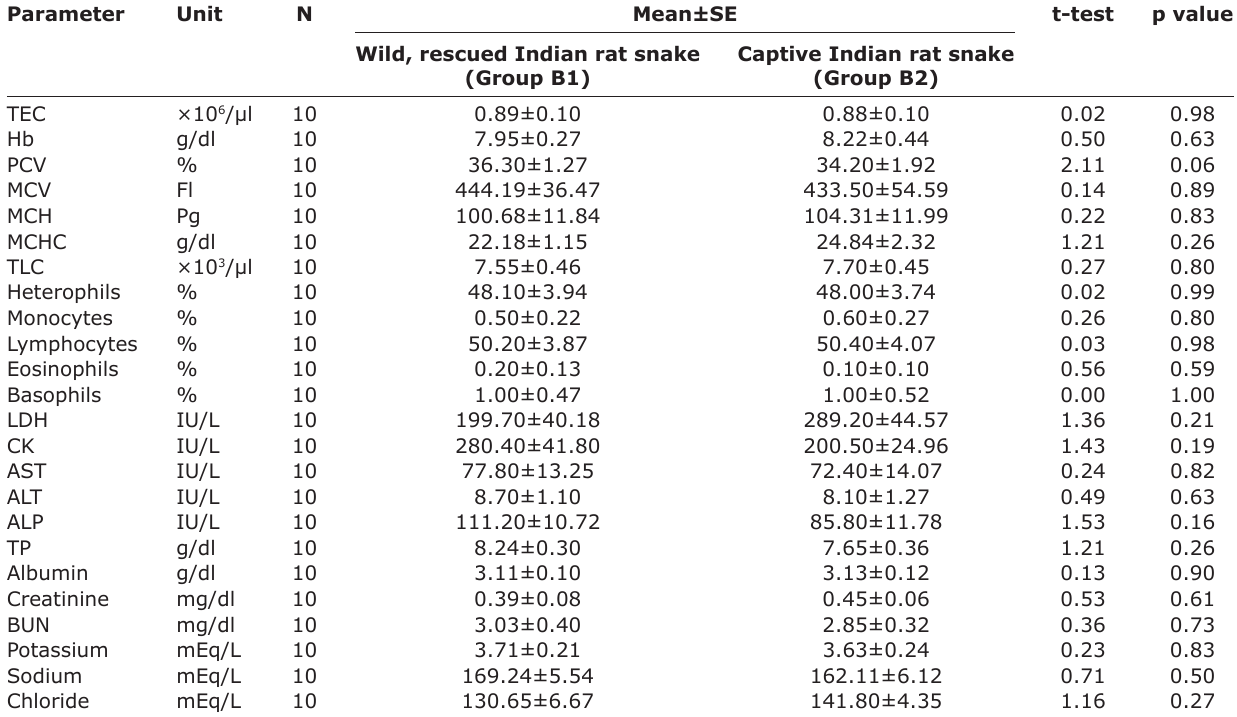
Table-2: Hematology and biochemistry values observed for wild and captive Indian rat snake ( P. mucosa ) with statistical data.